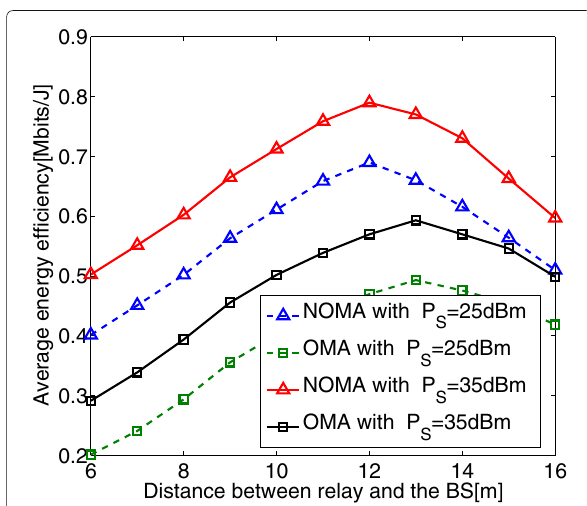
Fig. 8 Average energy efficiency versus distance between relay and the BS